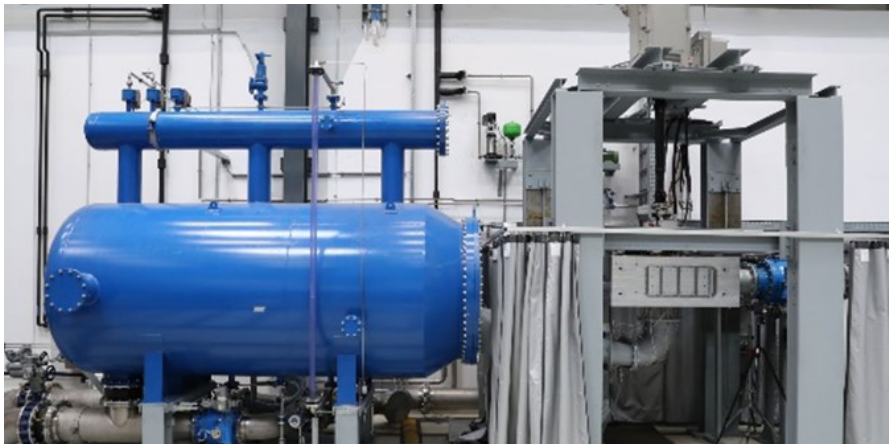
Figure 6. Test rig with scale reduced model of a radial pump turbine at the hydraulic lab of the Institute of Energy Systems and Thermodynamics, TU